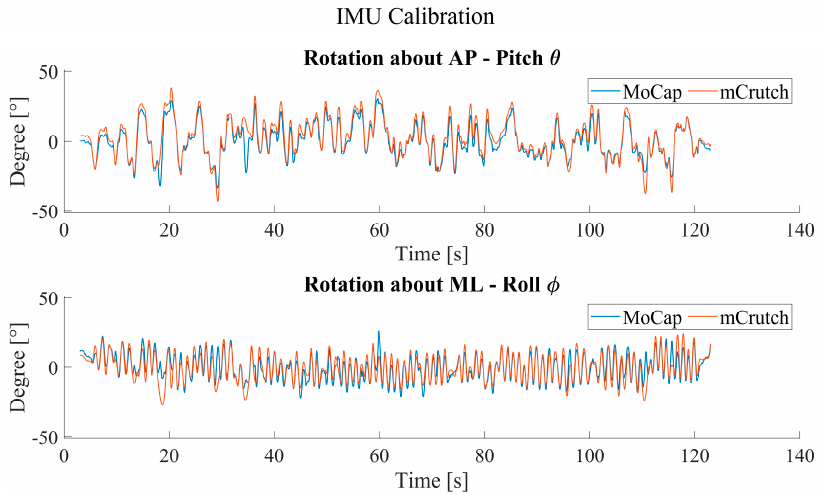
Figure 11. Orientation calibration performance.